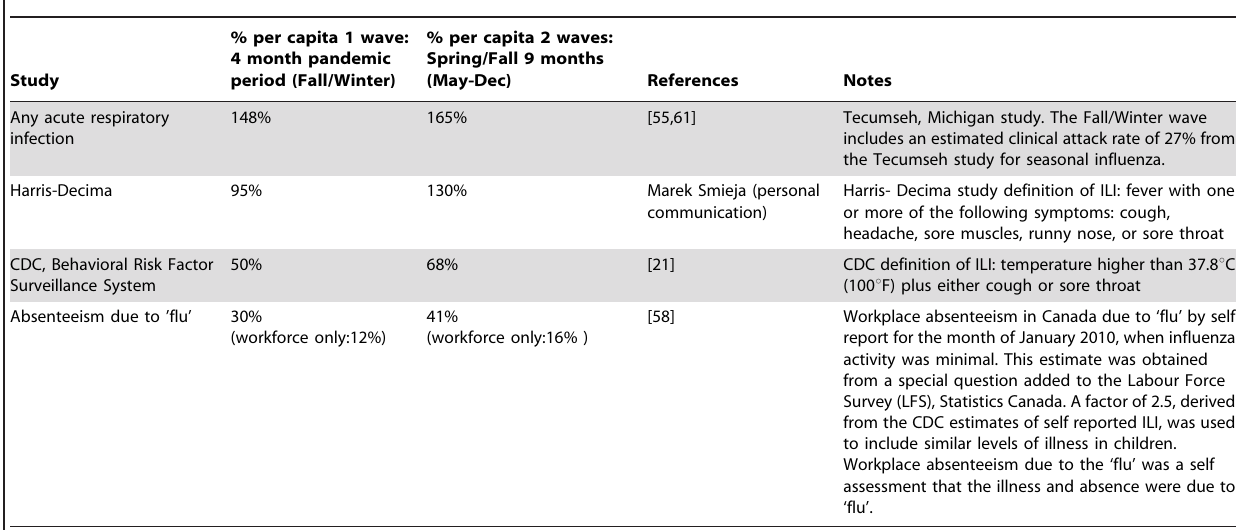
Table 1. Additional Assumptions for the calculation of antiviral stockpile: Number of baseline respiratory infections per pandemic period per capita meeting various ILI